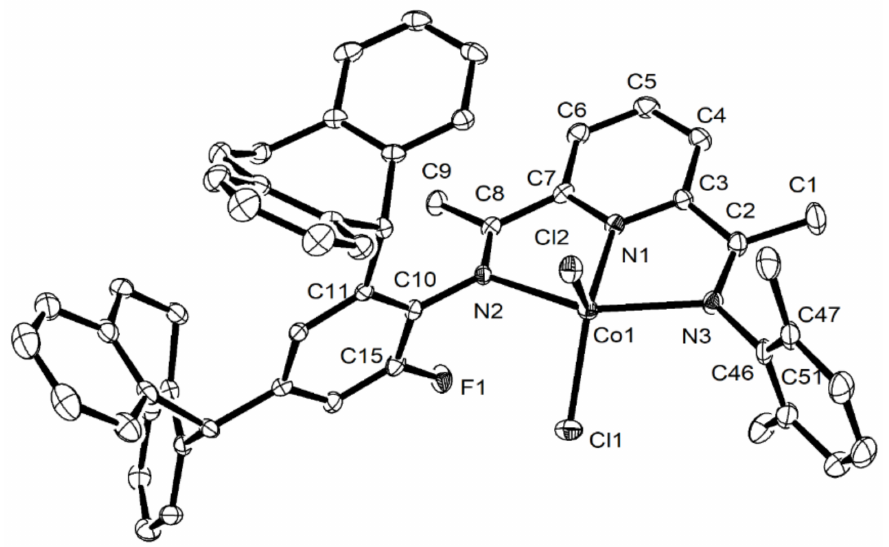
Figure 2. ORTEP representation of Co1 with the thermal ellipsoids set at 30% probability level. All hydrogen atoms have been omitted for clarity.